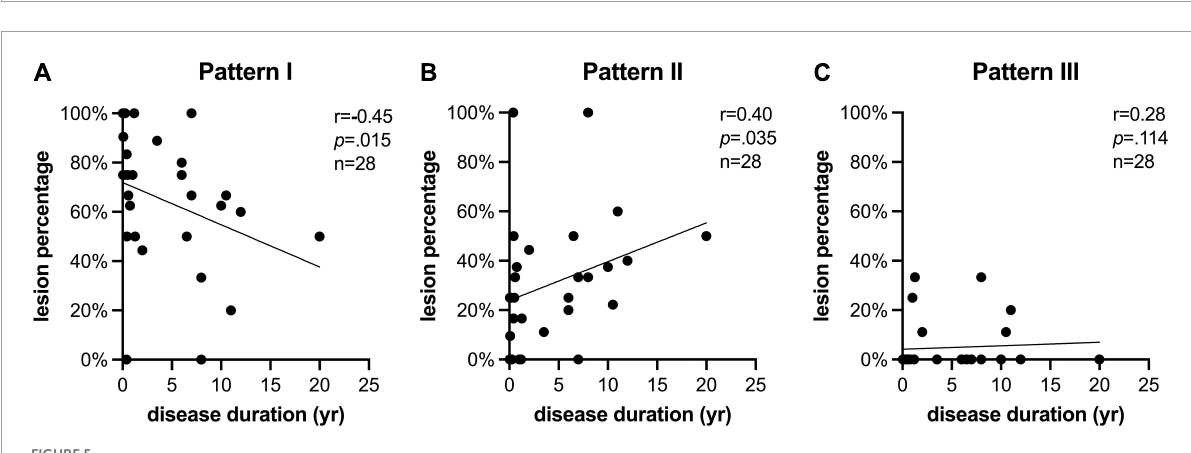
from a higher level to a lower one. The change in the percentage of Pattern I lesions with disease duration might reflect such evolution of chronic inflammation. As for the change in the percentage of Pattern II lesions, it may